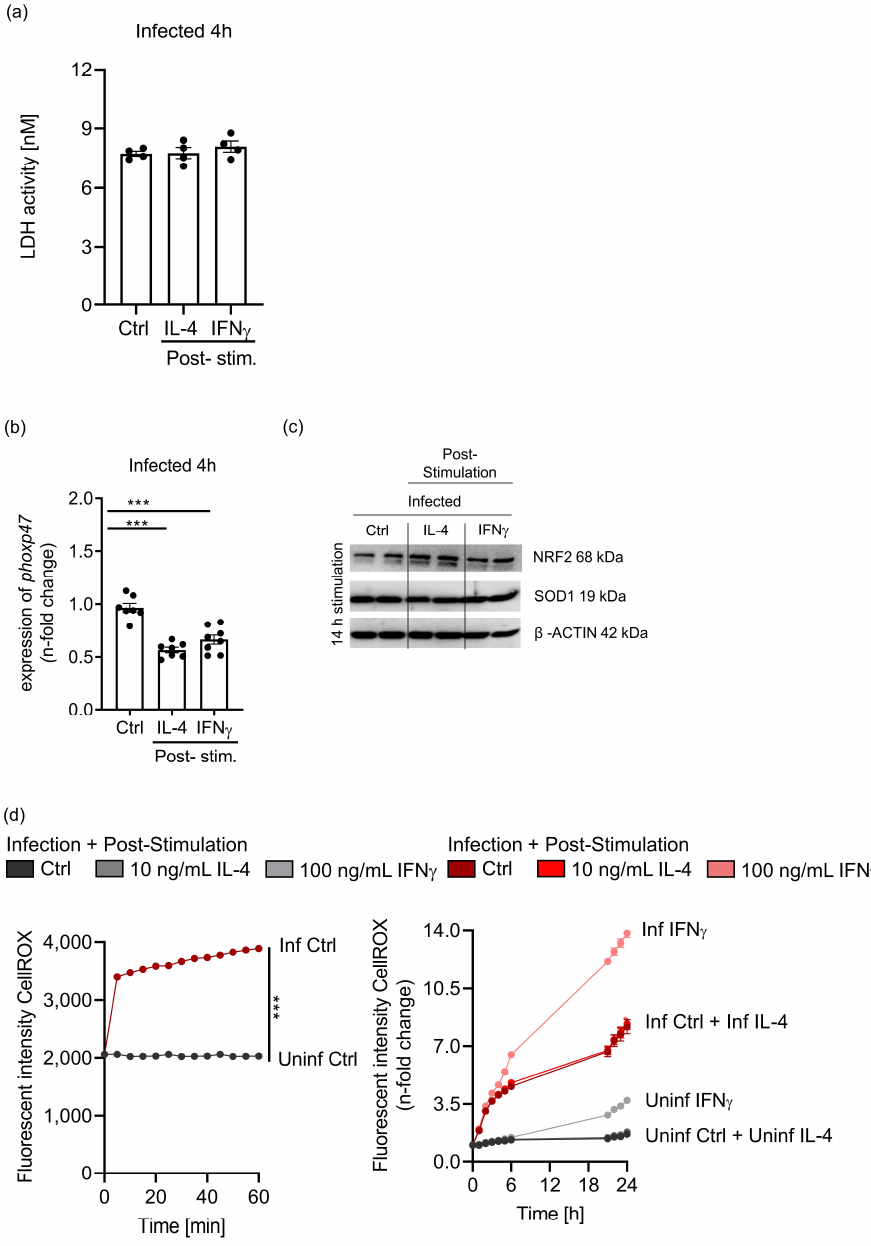
Figure 7. IL-4 stimulation of unpolarised S .tm-infected BMDM does not affect cellular viability, radical formation and expression of radical detoxifying enzymes. Unpolarised BMDM were infected with S .tm for 1 h. Afterwards, cells were stimulated (post-stimulation) with 10 ng/mL IL-4, 100 ng/mL IFN γ or left unstimulated as indicated. ( a ) Determination of cell viability by analysing LDH activity after 4 h post-stimulation. ( b ) Phoxp47 transcript levels due to infection and 4 h post-stimulation were determined by quantitative real-time PCR and normalized to Hypoxanthine phosphoribosyltransferase ( Hprt ) mRNA levels using the ΔΔ CT method. Data were normalised to the infected Ctrl. ( c ) Western blot analysis of SOD1, NRF2 and β -ACTIN expression after 14 h. ( d ) Quantification of ROS formation using the CellROX TM reagent, during a 1 h infection period (left) and during a gentamicin neutralisation assay and post-stimulation over the course of 24 h. Time course data were normalised to the levels of the 30 min unstimulated uninfected Ctrl. Statistical significance was determined by one-way ANOVA with Tukey post hoc test for three groups and two-way ANOVA with Tukey post hoc tests for more groups: *** p -value < 0.001. Representative data (mean ± SEM) from two to three independent experiments with two technical replications are